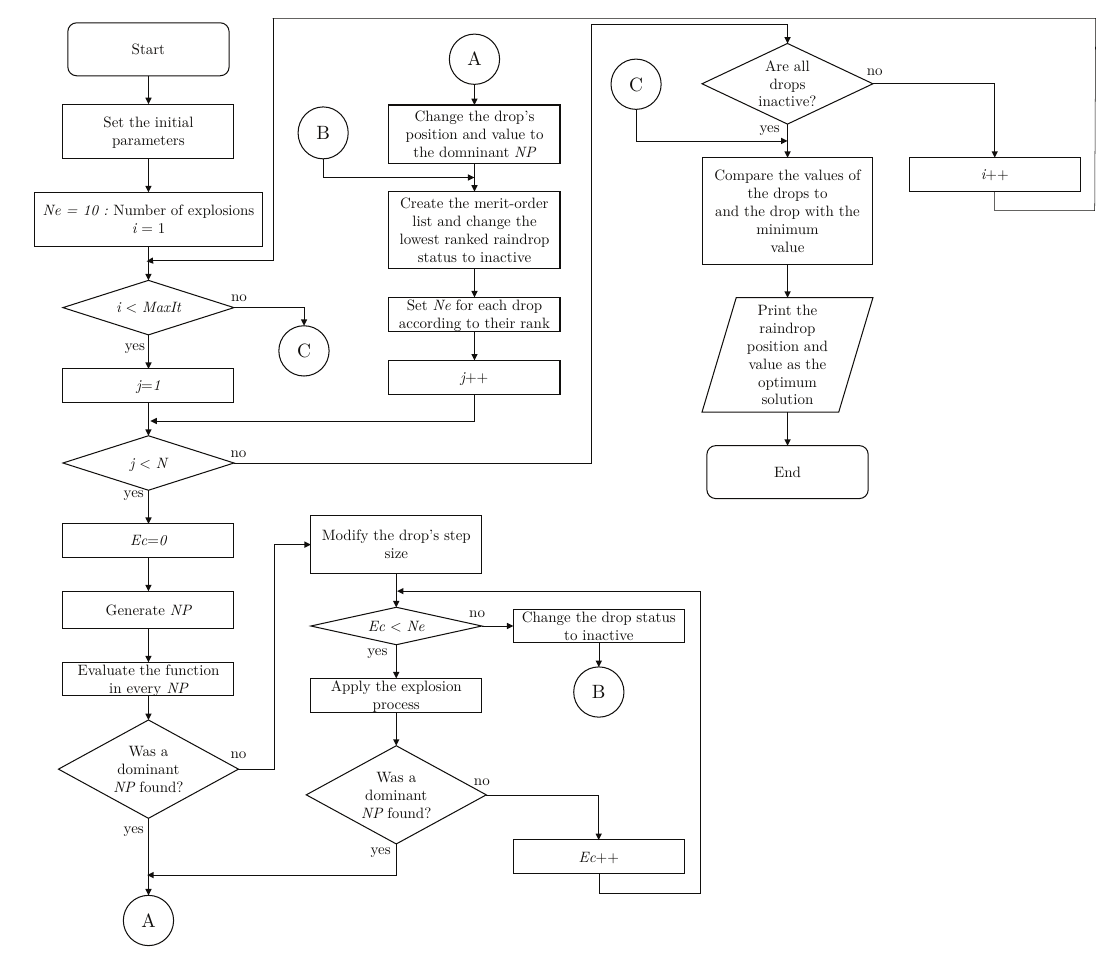
Figure 1. Flowchart of the RFO